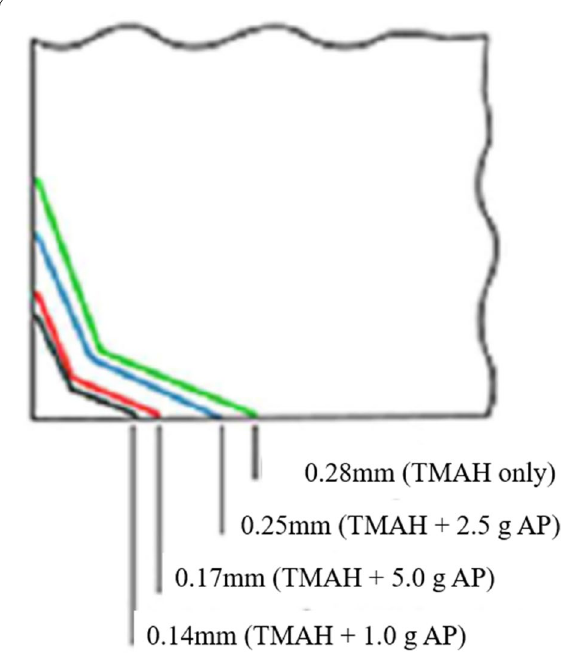
Fig. 52 Undercutting at convex corners on Si{100} surface without and with various concentrations of ammonium persulfate (AP) in 10 wt% TMAH at 70 °C [109], © 2015,